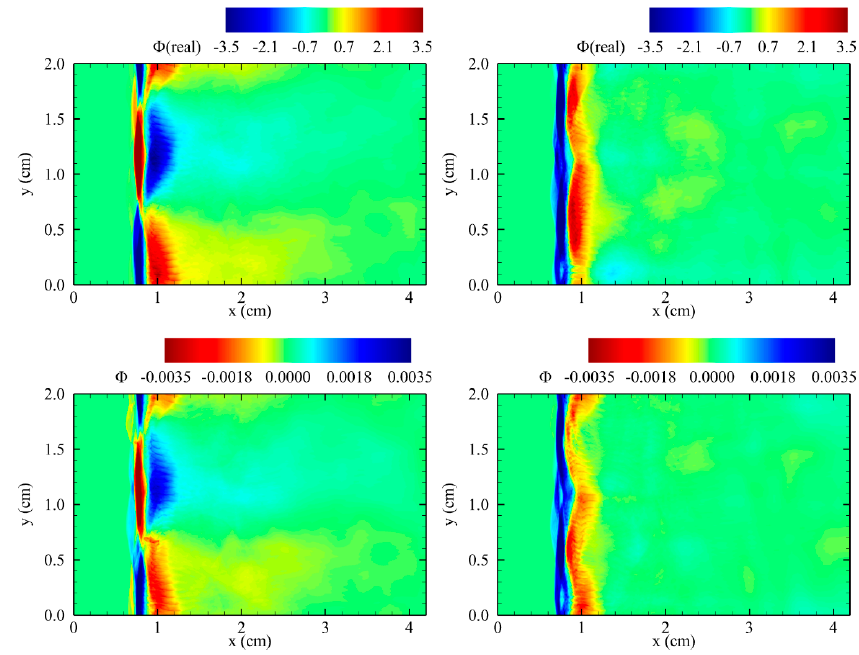
Figure 18. POD ( top ) and DMD ( bottom ) modes of the weakly unstable detonation